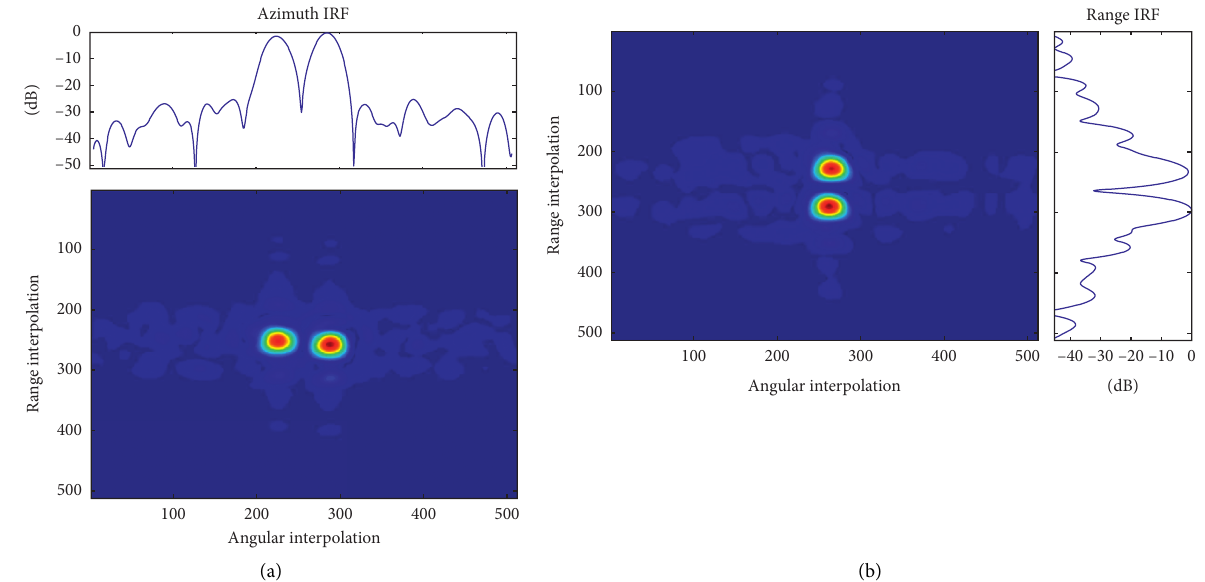
Figure 8: Images and IRFs. (a) Imaging result and azimuth IRF of the reflector in circle “1”; (b) imaging result and range IRF of the reflector in circle